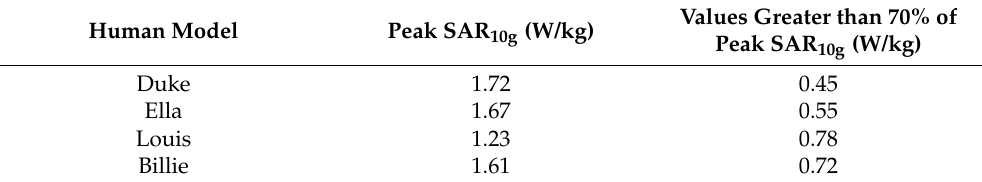
Table 3. Peak SAR 10g and percentage of SAR 10g values greater than the 70% of the peak SAR 10g for each